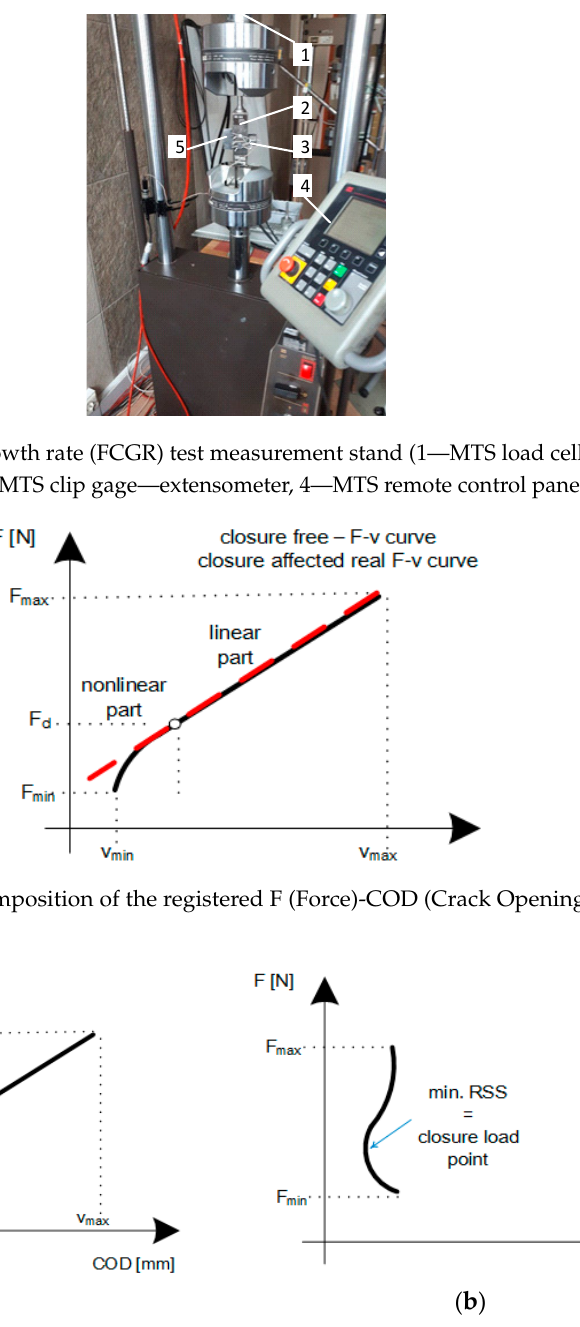
Figure 7. Closure point identification procedure from the recorded hysteresis loop. ( a ) Crack closure point laying on the registered F-COD curve; ( b ) value of F cl , for which the SSE value is the smallest— ξ [9,10].